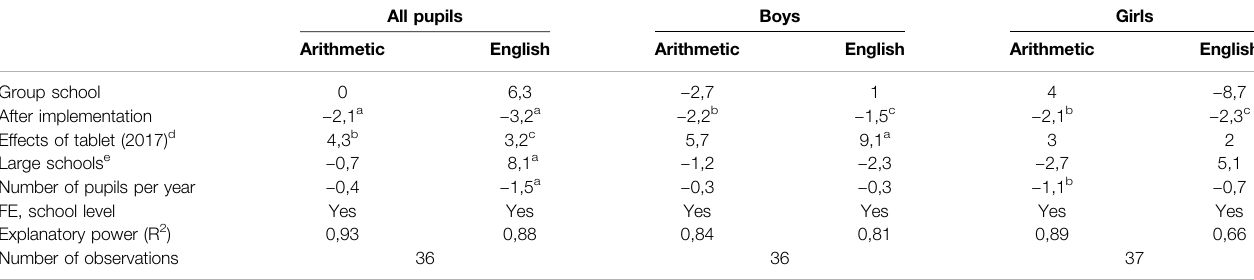
TABLE 4 | Diff-in-diff in fi xed effect regression analysis in fi fth grade (Pilot 1 schools).